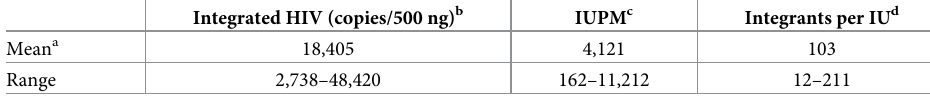
Table 1. Quantification of HIV latent infection at the end of